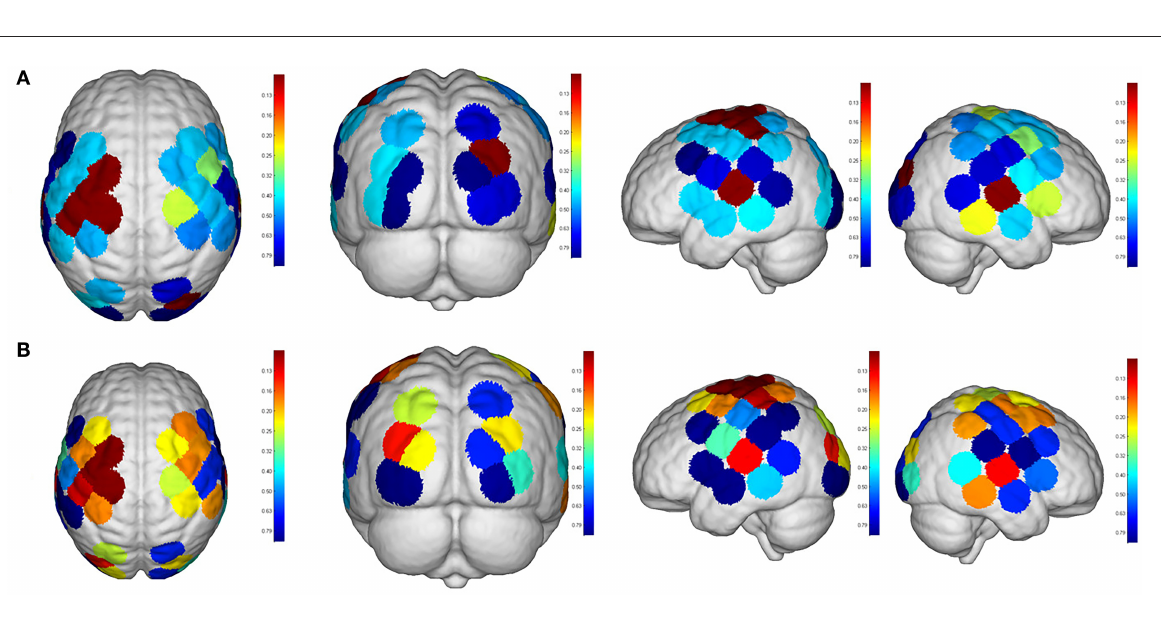
FIGURE8 Comparisons of cortical activation between R1 and R3. R1: active mode; R3: passive mode; (A) : β value; (B) : featured value; color bar: 0.1 to